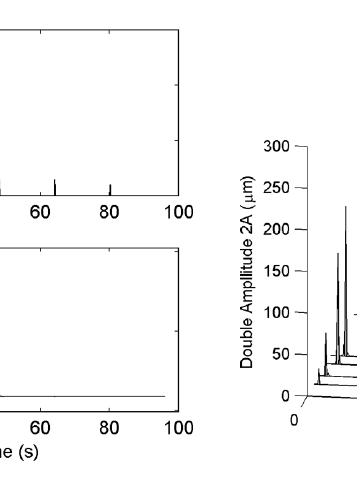
Fig. 9. Waterfall plot for double amplitude spectrum at UGB direction